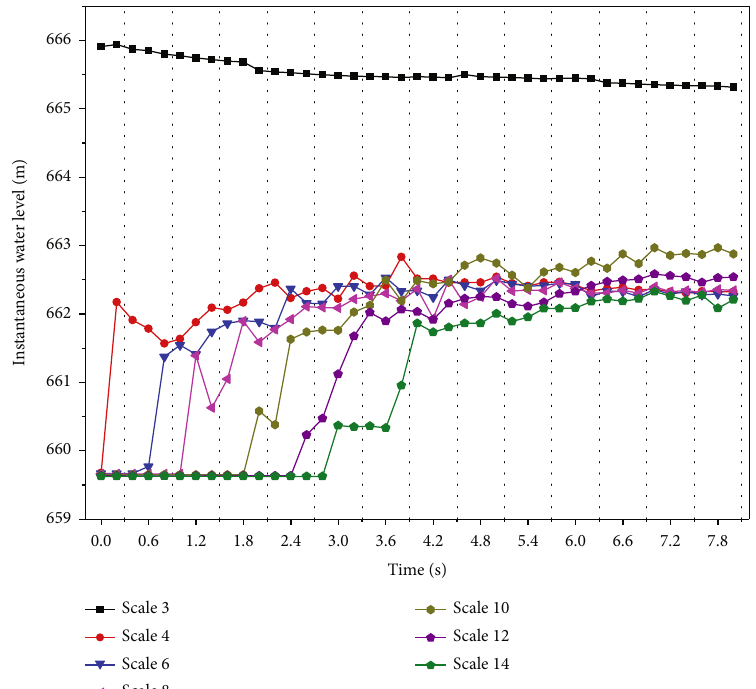
Figure 8: Instantaneous water level at each measuring point under operating condition 2 (interval 0.2s).